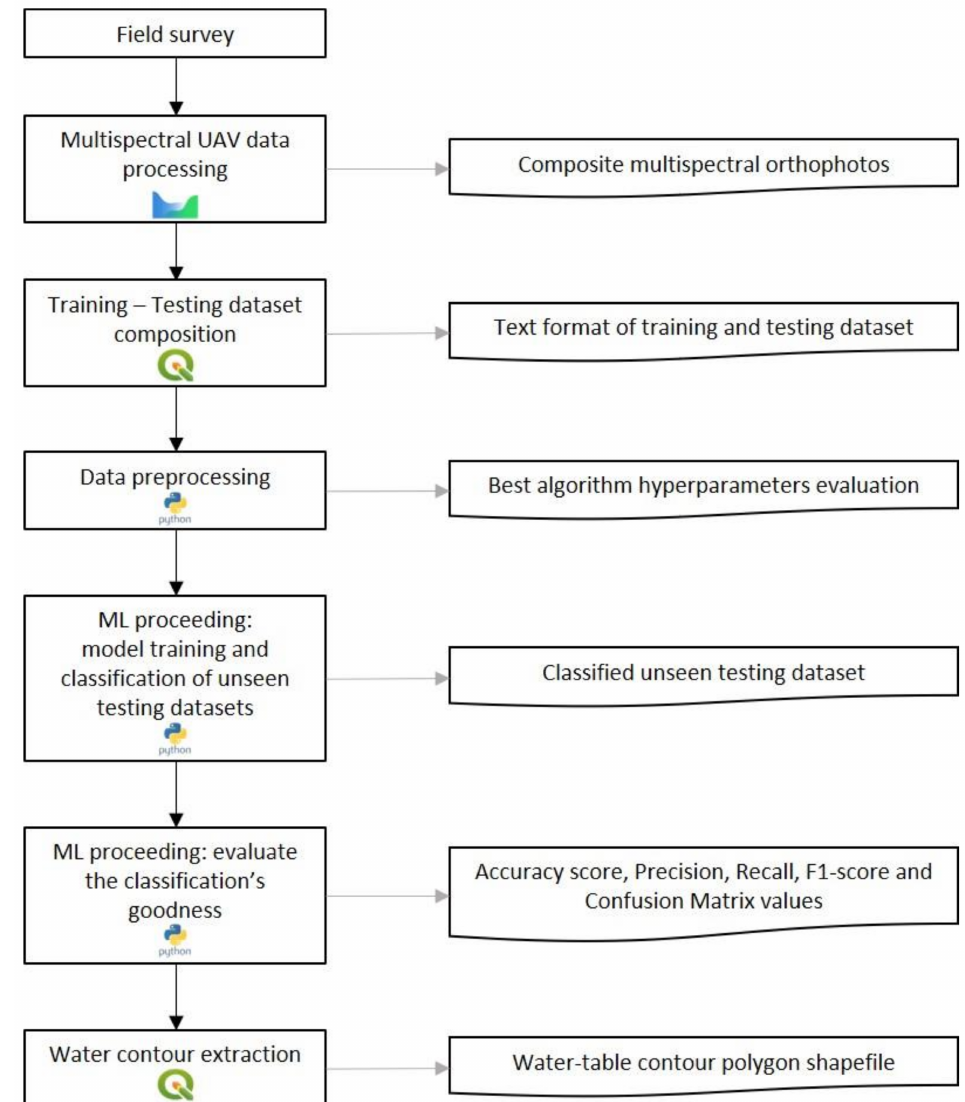
Figure 2. Methodology flowchart